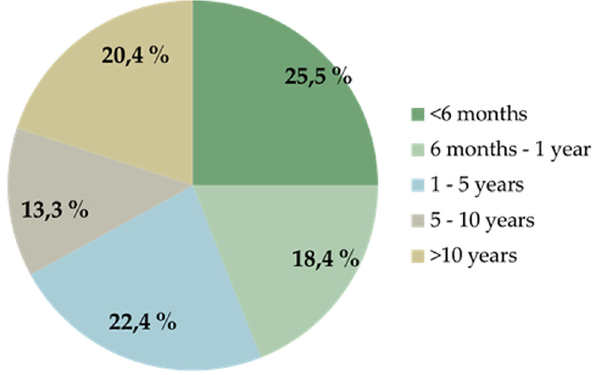
Figure 1: Duration of chronic spontaneous urticaria before plasmapheresis.